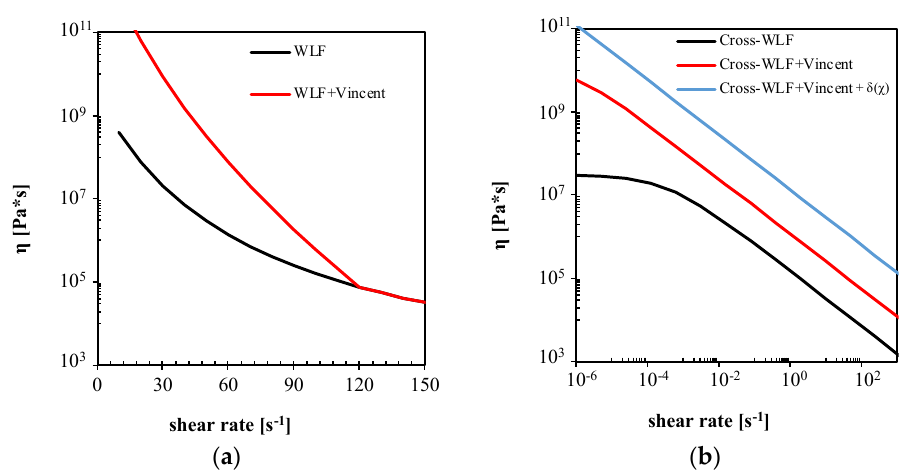
Figure 12. Modification of η 0 introduced by Vincent according to Equation (8) ( a ). Effect on T30G viscosity flow curve of the modification proposed by Vincent and considering a total crystallinity of 20% ( b ).